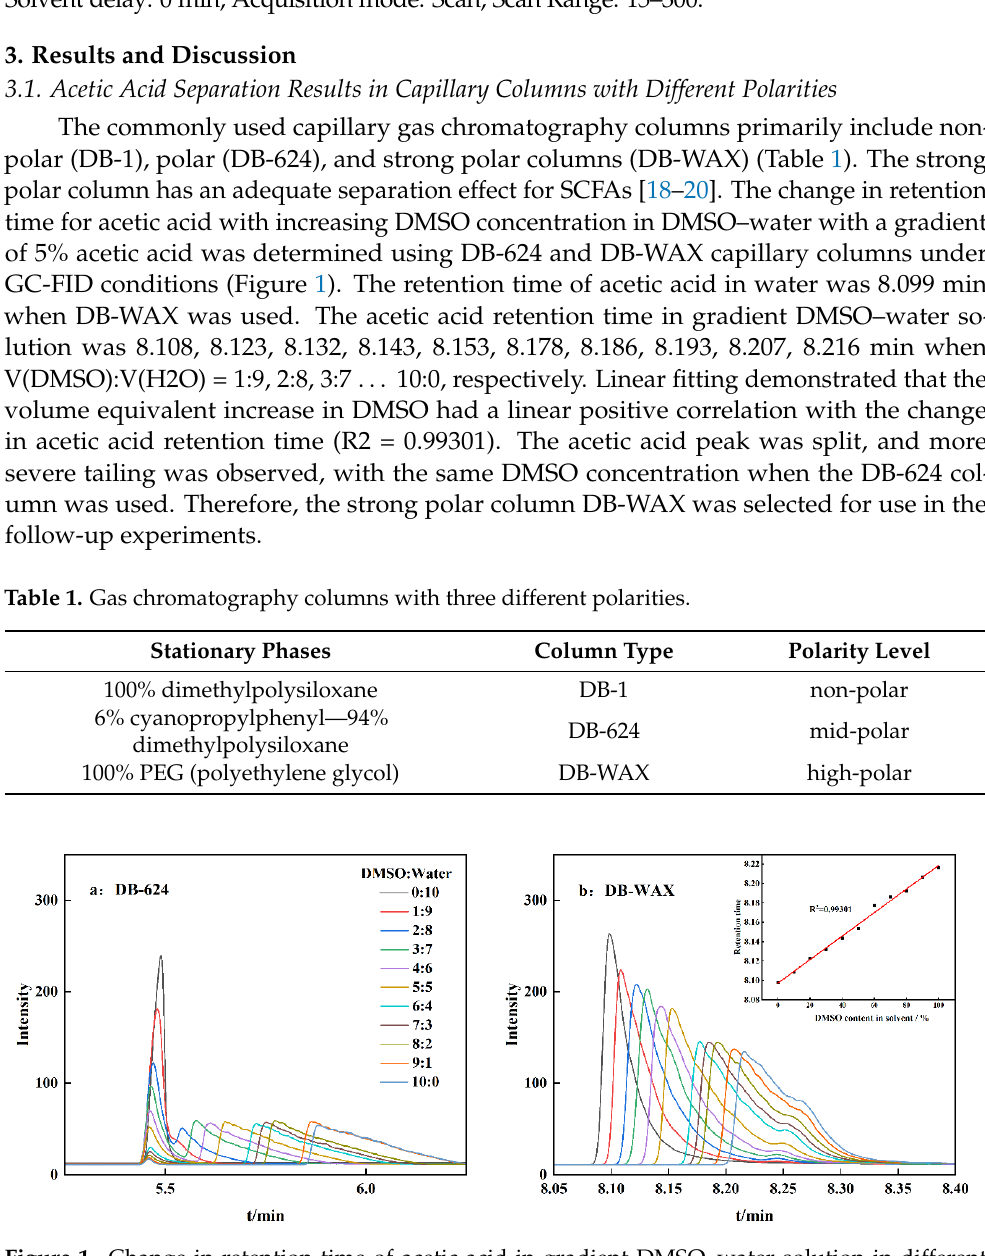
Figure 1. Change in retention time of acetic acid in gradient DMSO – water solution in different col- umns. ( a ) Result with DB-624 column; ( b ) result with the DB-WAX column. Table 1. Gas chromatography columns with three different